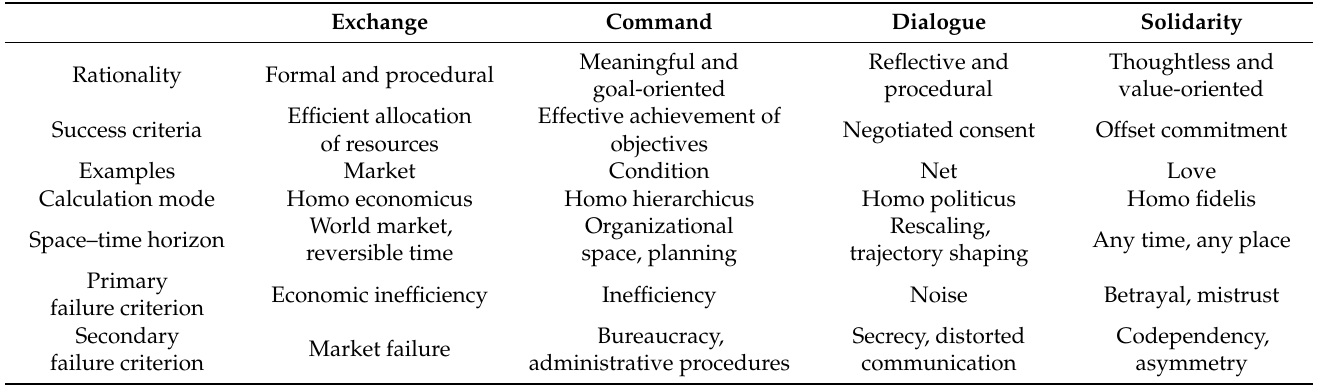
Table 1. Modes of